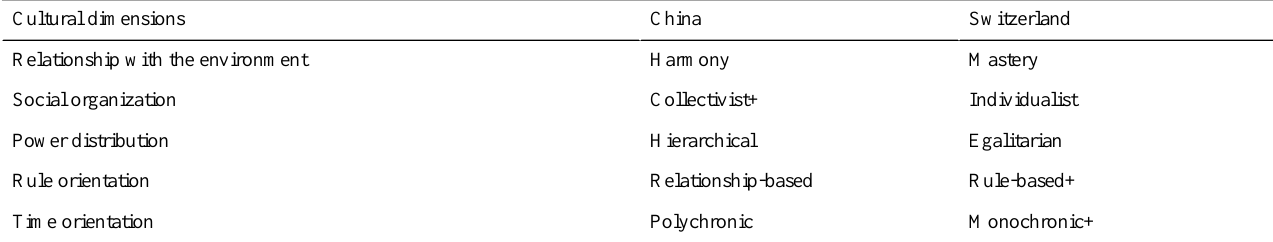
Table 2. Country ratings of China and Switzerland in line with “Big Five” dimensions [14]. a